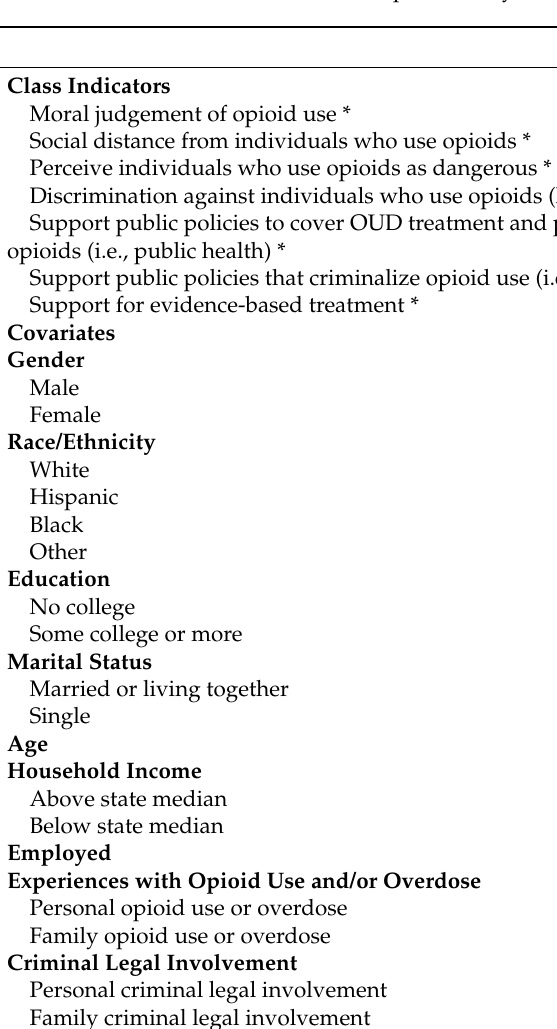
Table 1. Weighted distribution of outcomes and covariates: data from the nationally representative AmeriSpeak survey, February 2020 (n =